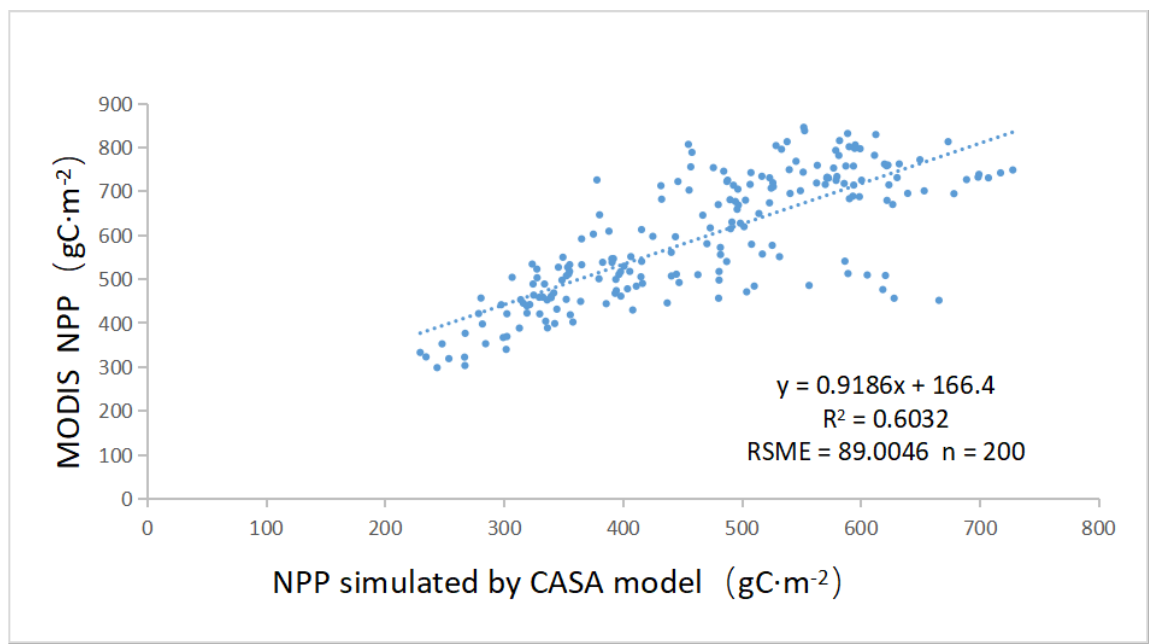
Figure A2. Comparison of NPP obtained from the CASA model and MODIS products in 2010.